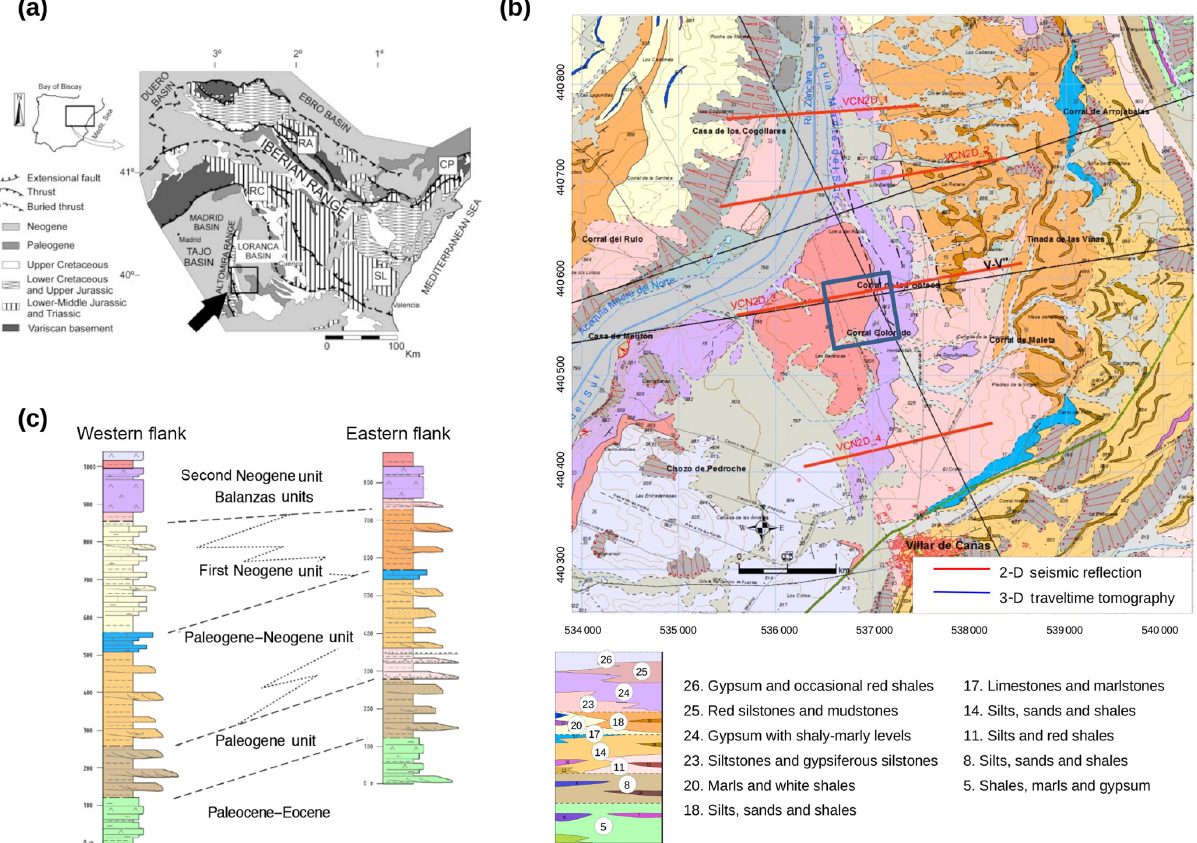
Figure 1. (a) Simplified geological map of the Iberian Chain in the eastern Iberian Peninsula, with the location of the study area marked by a black box (modified from Guimerà et al., 2004). (b) Local geological map of the Villar de Cañas syncline. The target area is marked by a blue rectangle. The 2-D seismic reflection profiles acquired in this experiment are also located in the map. (c) Detailed stratigraphic columns describing the main units observed in both flanks of the